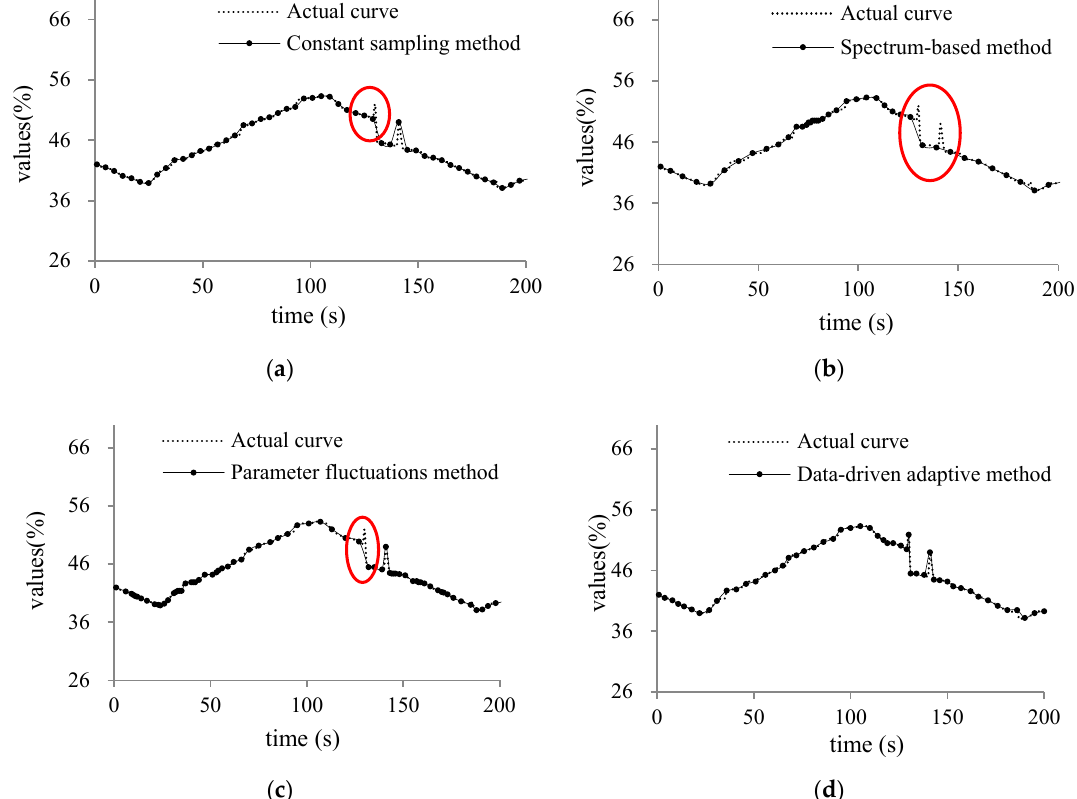
Figure 7. ( a ) constant sampling curve of humidity; ( b ) spectrum-based curve of humidity; ( c ) parameter fluctuations curve of humidity; ( d ) data-driven adaptive curve of humidity.